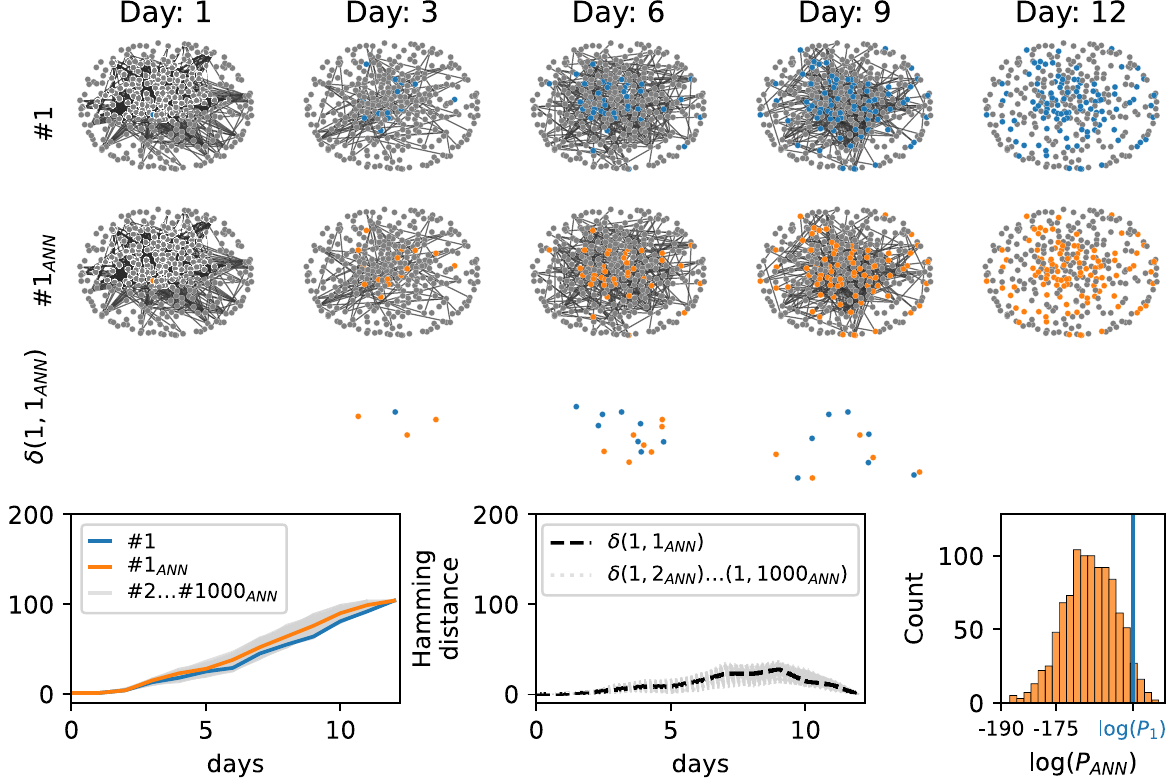
Figure 3. Epidemics cascades generated by the ANN. Epidemic cascades generated by the ANN trained on a posterior probability composed by a prior, the epidemic model that generate the blue cascade, and the evidence, its final configuration at day 12. The contact network is a real contact graph measured in a hospital 22 . An example of the epidemic cascade generated is shown in second row ( 1 ANN , orange). The third row represent the hamming distance between them (see caption Fig. 1). Left-bottom plot. Cumulative number of infected individuals for epidemic cascade simulated (blue curve) and generated by the ANN ( i ANN ∈ [ 1, 2 . . . 1000 ] . Central-bottom plot. Hamming distance ( δ( 1, i ANN ) between blue epidemic cascade and those generated by the ANN i ANN ∈ [ 2, 3 . . . 1000 ] . Right-bottom plot. Distribution of the values of the prior probability of the generated epidemic cascades ( P ANN ). The blue vertical line is the value of the prior probability of the blue cascade ( log ( P i